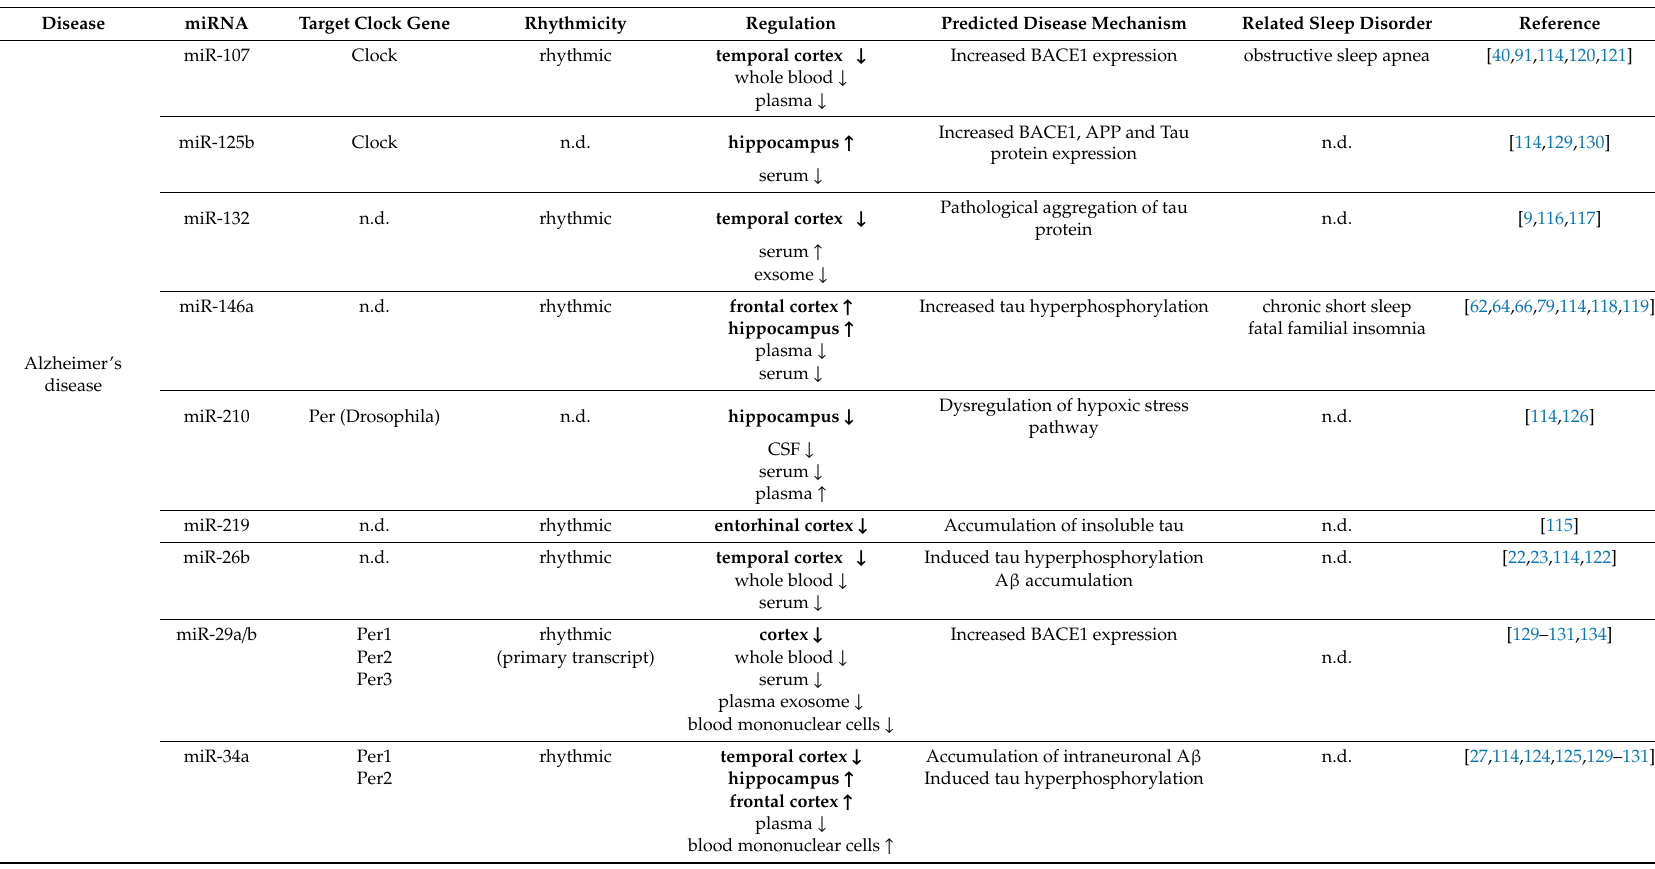
Table 1. Dysregulated miRNAs in the patient with neurodegenerative diseases, which is related to the regulation of clock genes or sleep disorders.